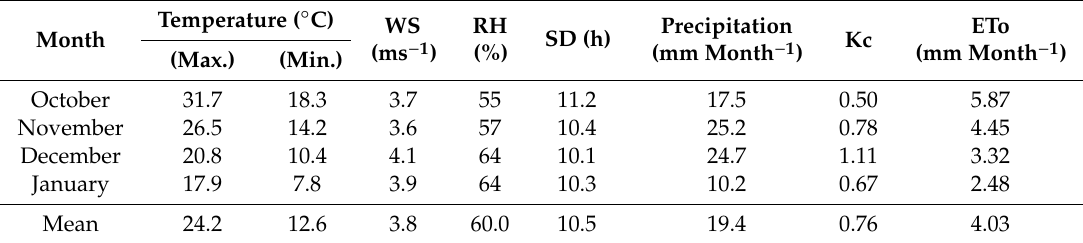
Table 3. Meteorological data of the experimental site, crop coe ffi cient (Kc), and crop evapotranspiration (ETo) in the 2015 / 16 and 2016 / 17 seasons (the average of the two